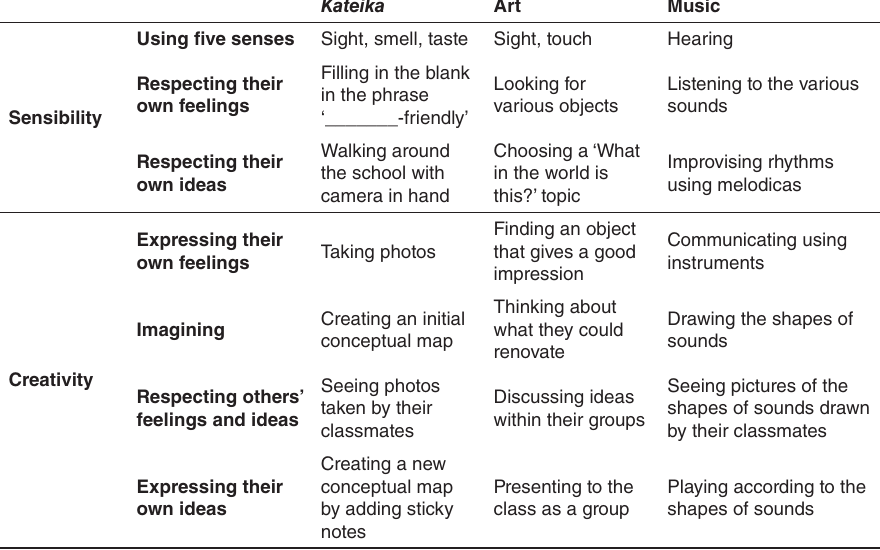
Figure 2: Procedure as an action research spiral